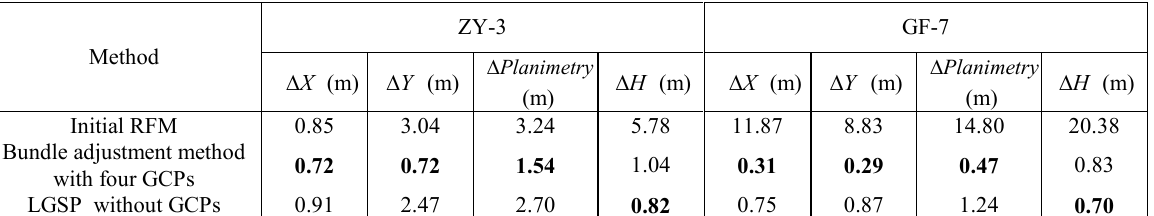
Table 2 . Bias of methods for processing satellite stereo image models.